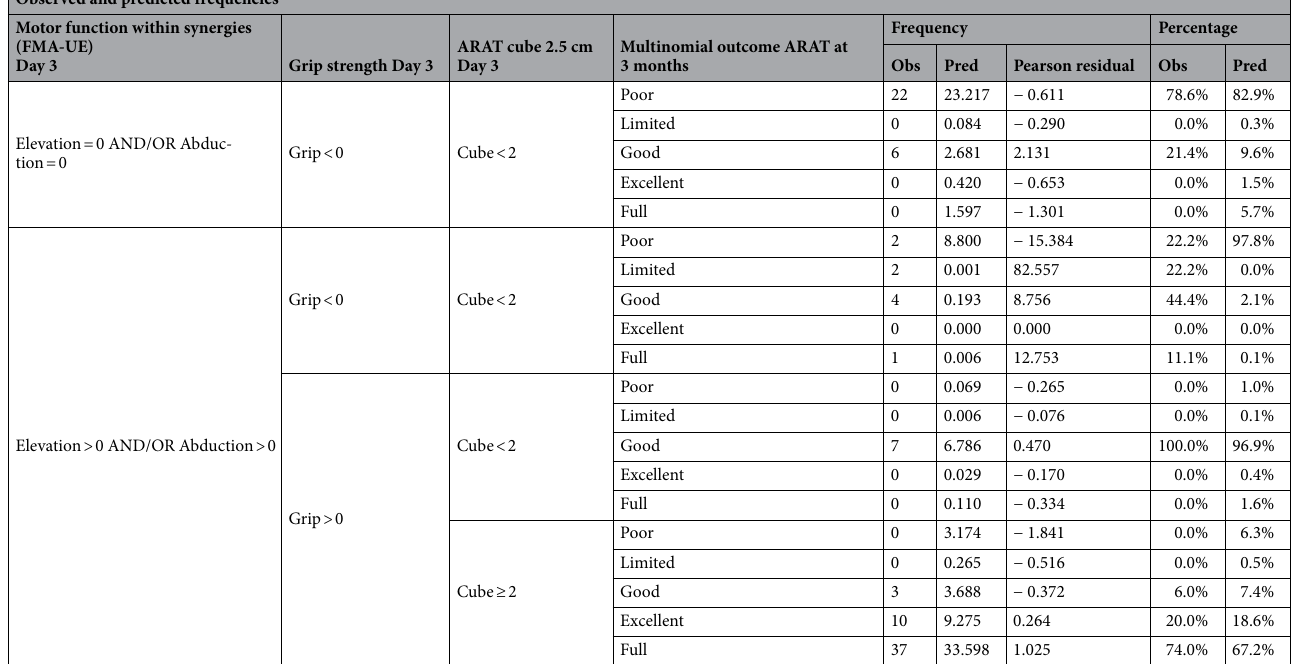
Table 3. Observed and predicted frequencies for prediction algorithm. The percentages are based on total observed frequencies in each subpopulation. ARAT Action Research Arm Test, FMA Fugl-Meyer